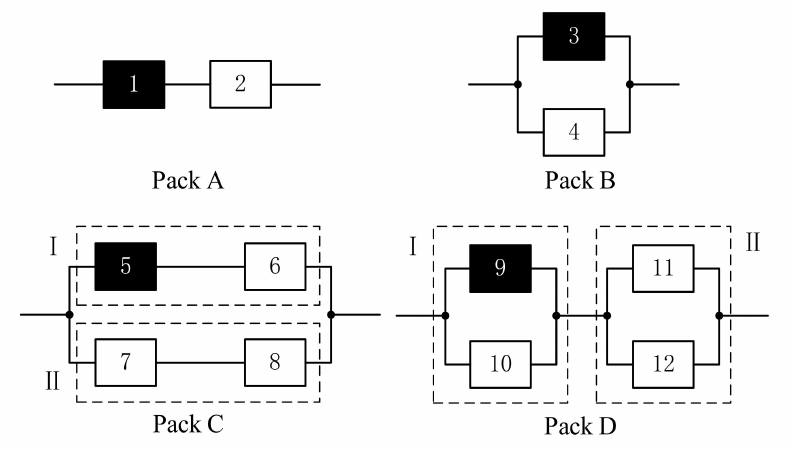
Figure 3. Configurations of the four battery